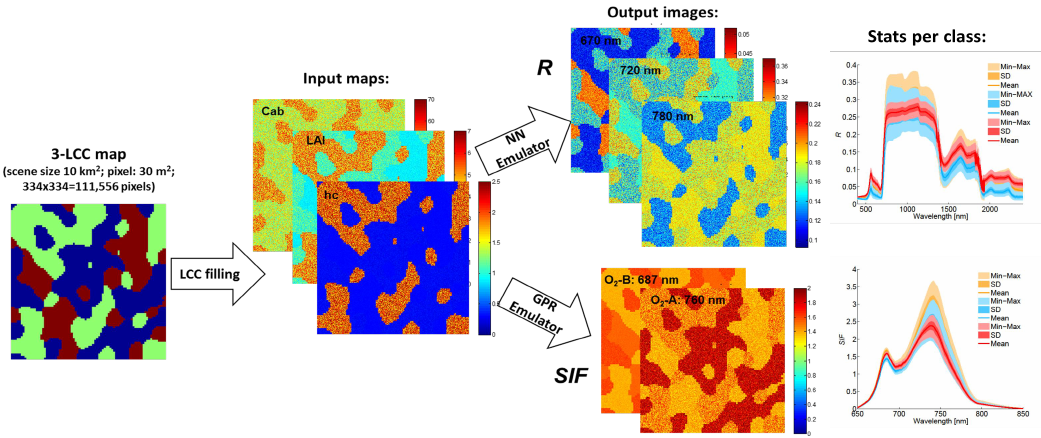
Figure 10. Illustration of A-SGM scene generation by using emulators. First a land cover map is arbitrarily created. Then these classes are filled with the input variables according to Table 2. Following the emulators are run to generate the spectral datacubes. For illustration, output images of a few wavelengths are shown. Also general statistics (mean, SD, min-max) per class are